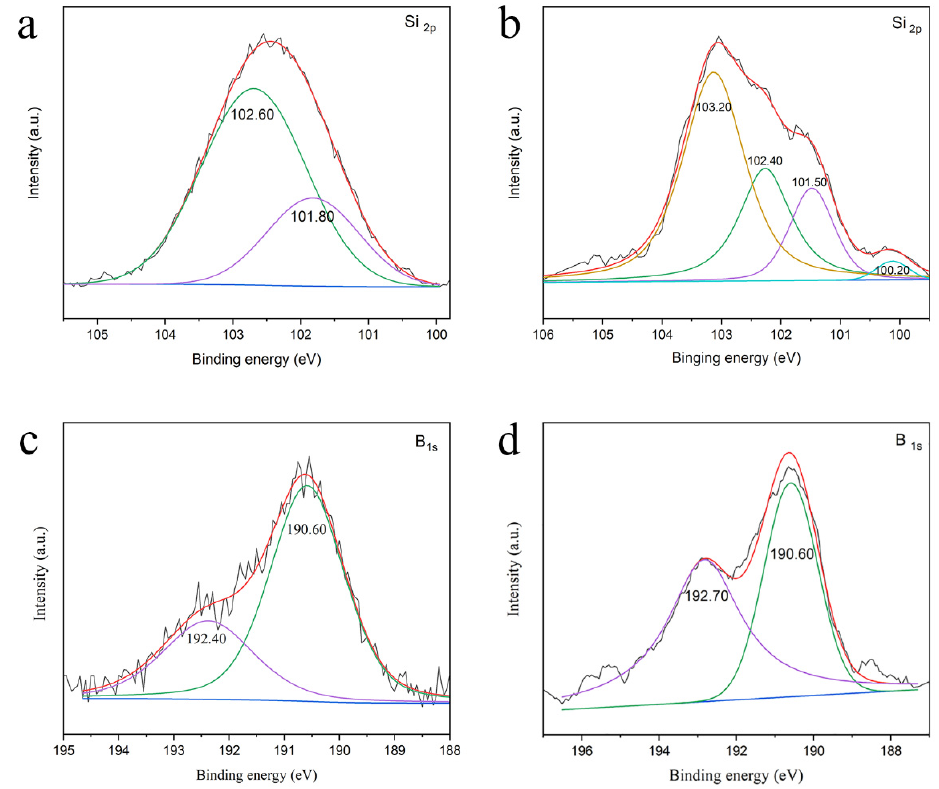
Figure 3. Si 2p spectra of SiBCN powder ( a ) and the pyrolyzed SiBCN phenolic resins at 1200 °C in Ar atmosphere ( b ), B 1s spectra of SiBCN powder ( c ) and the pyrolyzed SiBCN phenolic resins at 1200 °C in Ar atmosphere ( d ). After 2 h pyrolysis at 1200 °C in an Aar atmosphere, the cured SiBCN phenolic resins shrunk but did not crack. Compared to the volume shrinkage ratio of phenolic resins (31.11%), that of cured SiBCN phenolic resins was 24.31%, which indicated that the intro- duction of SiBCN powder contributed to enhancing the dimensional stability. Because SiBCN ceramic with excellent dimensional stability can restrain shrinkage of phenolic res- ins at pyrolysis process. As shown in Figure 4, the fracture morphology of the pyrolyzed SiBCN phenolic resins (1200 °C, 2 h) was observed by SEM and the element content of SiBCN powder surface was analyzed by EDS. The result illustrated that SiBCN powder reacted with the pyrolysis atmosphere of phenolic resin to generate oxides on the surface of the powder.